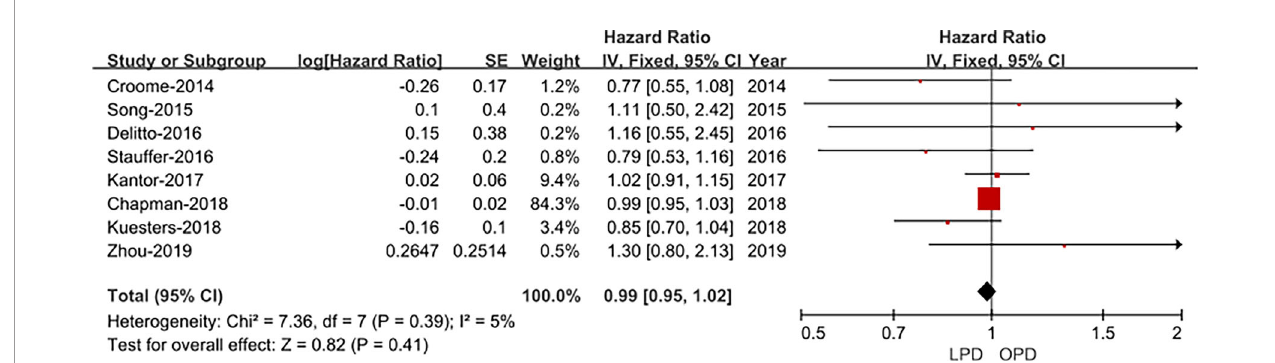
FIGURE 6 | Forest plot of the comparison of LPD versus OPD for overall survival time.